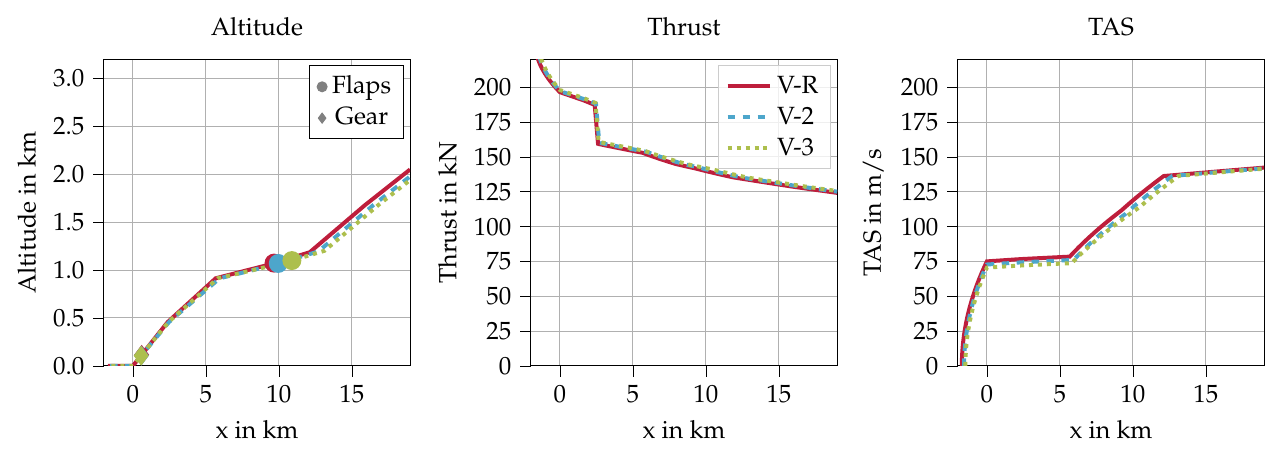
Figure 8. Departure trajectories: current engine option (BPR = 6).